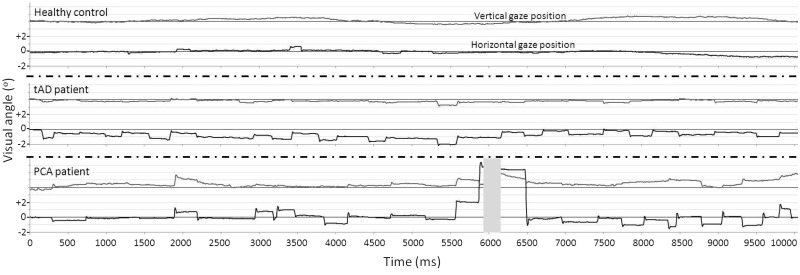
Representative traces from the fixation task in a healthy control, a patient with typical Alzheimer’s disease and a PCA patient. The upper plot (grey line) for each participant shows gaze position in the y (vertical) axis, the lower plot (black line) shows gaze position in the x (horizontal) axis. The location of the target stimulus is represented by thin black lines behind the traces. Gridlines show displacement of 1° of visual angle. The grey area in the plot for the PCA patient represents a blink (therefore x and y gaze coordinates are not available for this period). Positive values of gaze position indicate rightward gaze. The healthy control maintains steady fixation upon the target, whilst both patients show saccadic intrusions in the form of square-wave jerks. Additional large saccadic intrusions are evident in the PCA trace. tAD = typical Alzheimer’s disease.